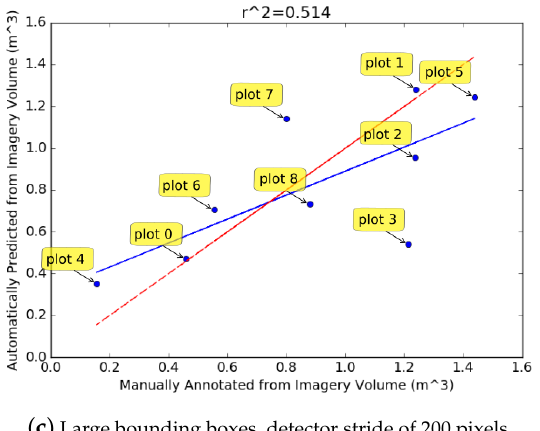
Figure 13. Comparison of plot log volume (excluding stumps) from UAV calculated from automated vs manual, digital-annotations of logs/coarse woody debris, with the predicted diameter of each log scaled down. Three different methods for detection are compared: ( a ) Small bounding boxes, detector stride of 100 pixels; ( b ) Large bounding boxes, detector stride of 100 pixels; ( c ) Large bounding boxes, detector stride of 200 pixels. Blue line indicates a linear regression between the data points and red dotted line shows a unit-slope line representing a perfect one-to-one relationship for comparison. The correlation score is shown in the title for each